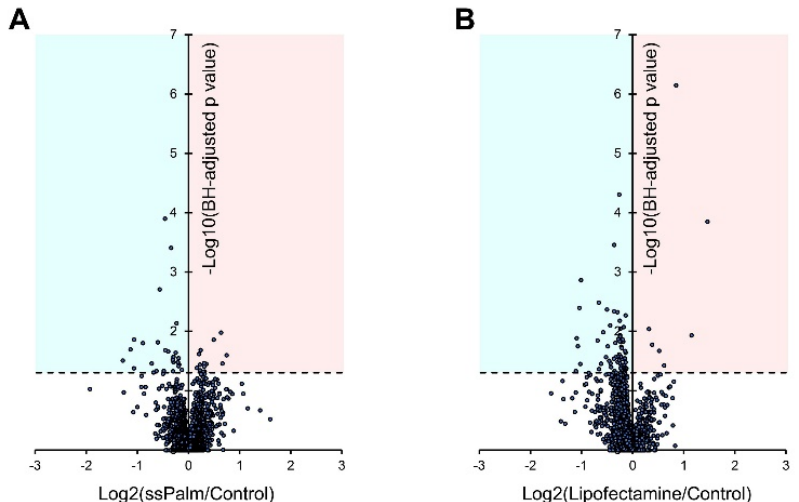
Figure 5. Volcano plot representation for the protein expression levels of all the quantified proteins by SWATH-MS analysis. The ssPalm-LNP ( A ) and LFN ( B ) were treated with hCMEC/D3 cells for 48 h at a concentration of 2.5 μg/mL. Then, the SWATH-MS analysis was performed for the whole cell lysate of hCMEC/D3 cells. The levels of expression of all the quantified proteins were compared with those in the control group ( n = 5–9). X-axis represents the log2 values for the fold changes in protein expression levels compared with the control group. Y-axis represents the minus log10 values of the Benjamini–Hochberg (BH) adjusted p values for the differences between two groups. Blue and red areas represent the down- and up-regulated proteins with p values less than